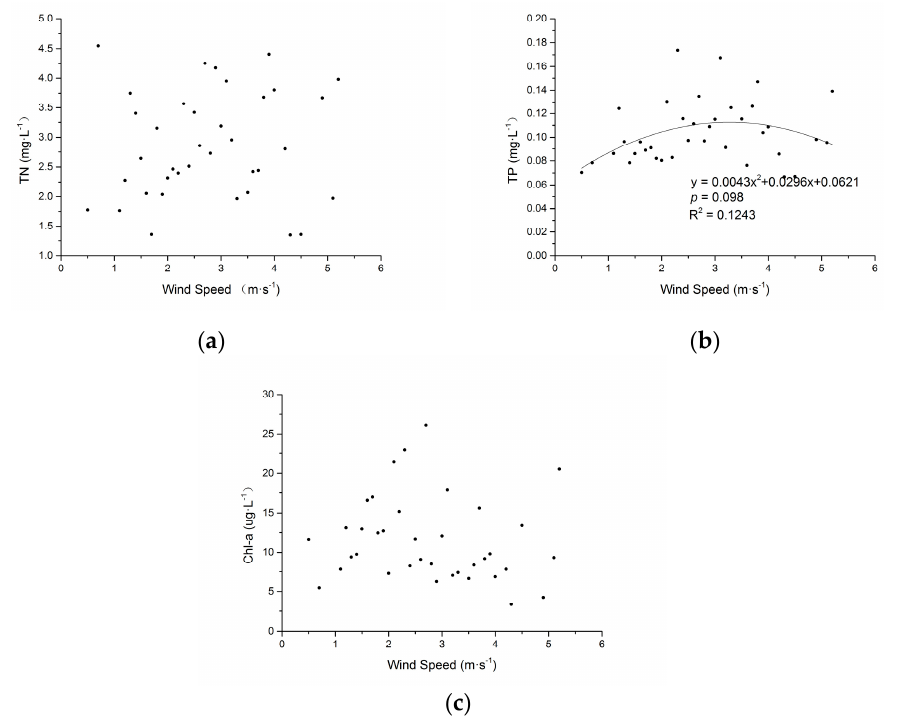
Figure 12. Plots showing wind speed versus median concentration of: ( a ) total nitrogen (TN); ( b ) total phosphorus (TP); and ( c ) chlorophyll-a (Chl-a), in Central Lake and East Lake (Figure 1).